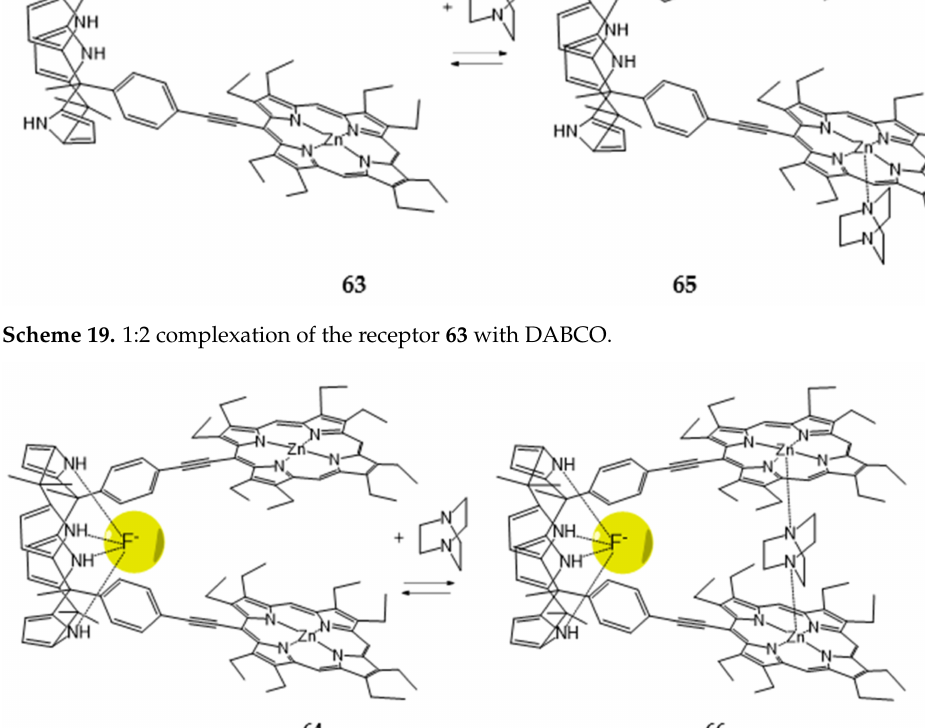
Scheme 20. 1:1 complexation of the receptor 63 with DABCO in the presence of F −